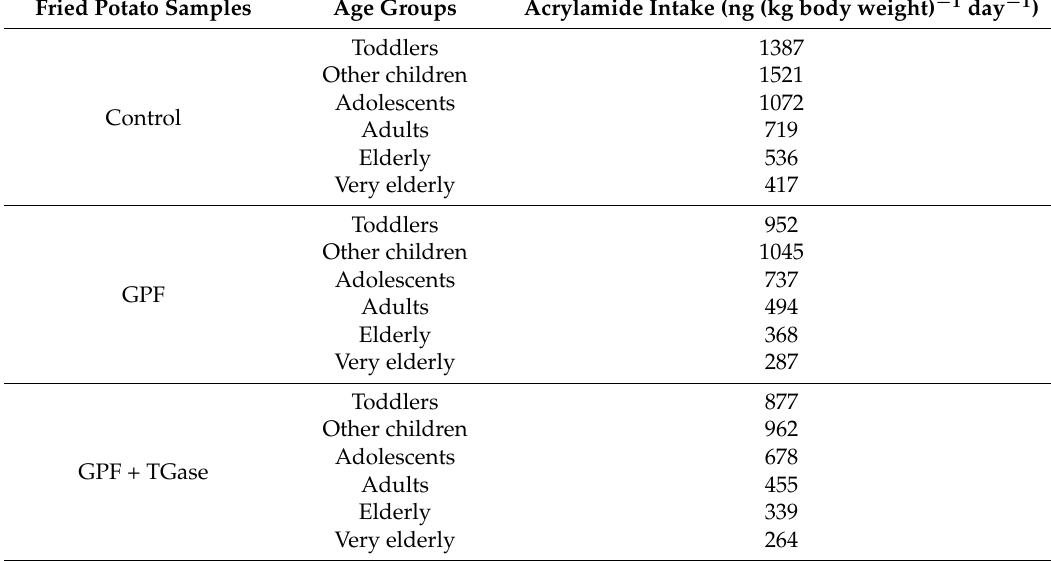
Table 1. Dietary intake of acrylamide consumption based on the median of the estimated consumption of fried potatoes treated with the coating solutions. Samples were coated with different hydrocolloid-based coatings made of GPF, grass pea flour; GPF + TGase, grass pea flour treated by transglutaminase; PEC, pectin; and CH, chitosan. “Uncoated” represents the control sample dipped in distilled